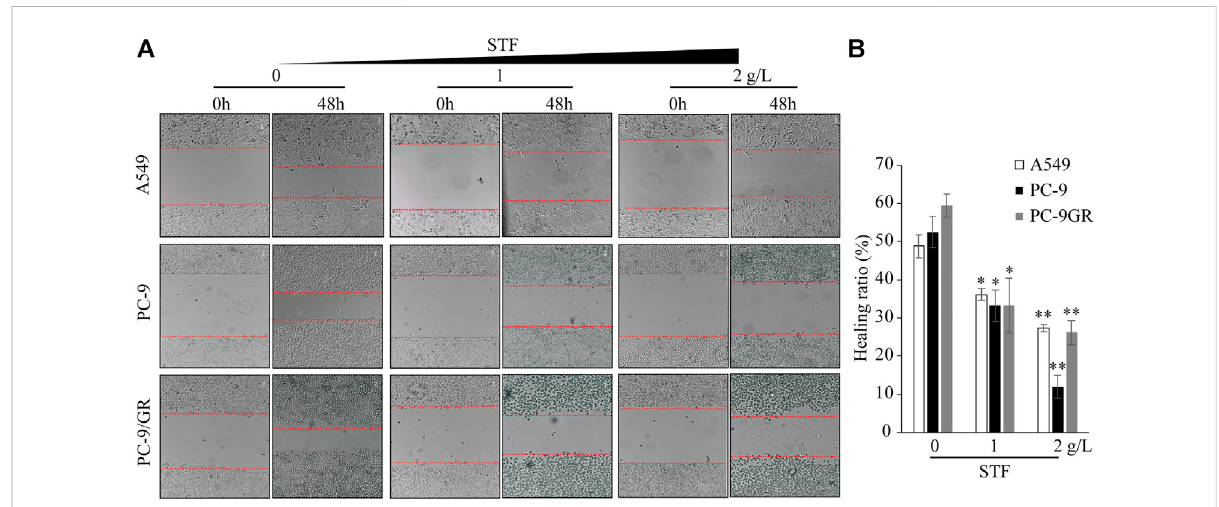
FIGURE 3 STFinhibitedthewoundhealingcapacityofNSCLCcells.A549,PC-9,and PC-9/GRcellswereplated overnight. Acell-freeareawasgenerated with apipette tip, and afresh medium containing differentconcentrations ofSTF was added for 48 h.Cell imagesof thecell-free gap werecaptured (A) and analyzed statistically (B) . * p < 0.05, ** p < 0.01.